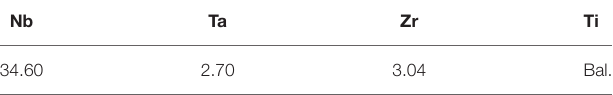
TABLE 1 | Chemical composition (wt.%) of the Ti-35Nb-2Ta-3Zr alloys. Nb